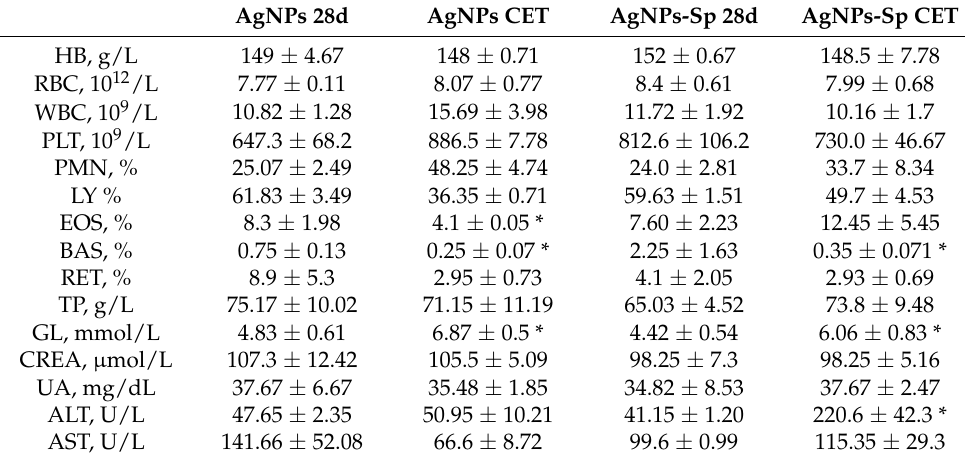
Table 1. Hematological and biochemical indicators in rats after 28 days of AgNPs administration and a clearance period of 28